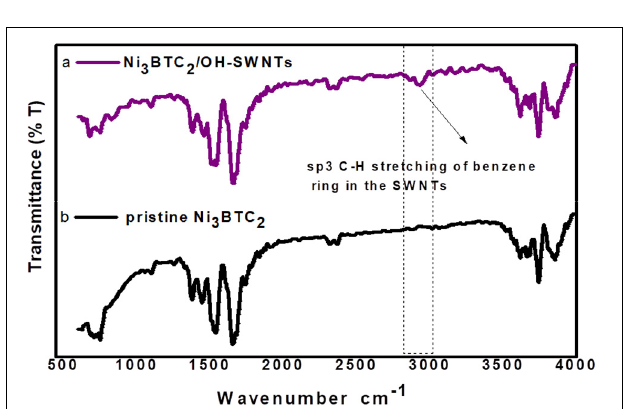
FIGURE 2 | XRD patterns, (a) pristine Ni 3 BTC 2 and (b) composite of Ni 3 BTC 2 /OH-SWNTs.